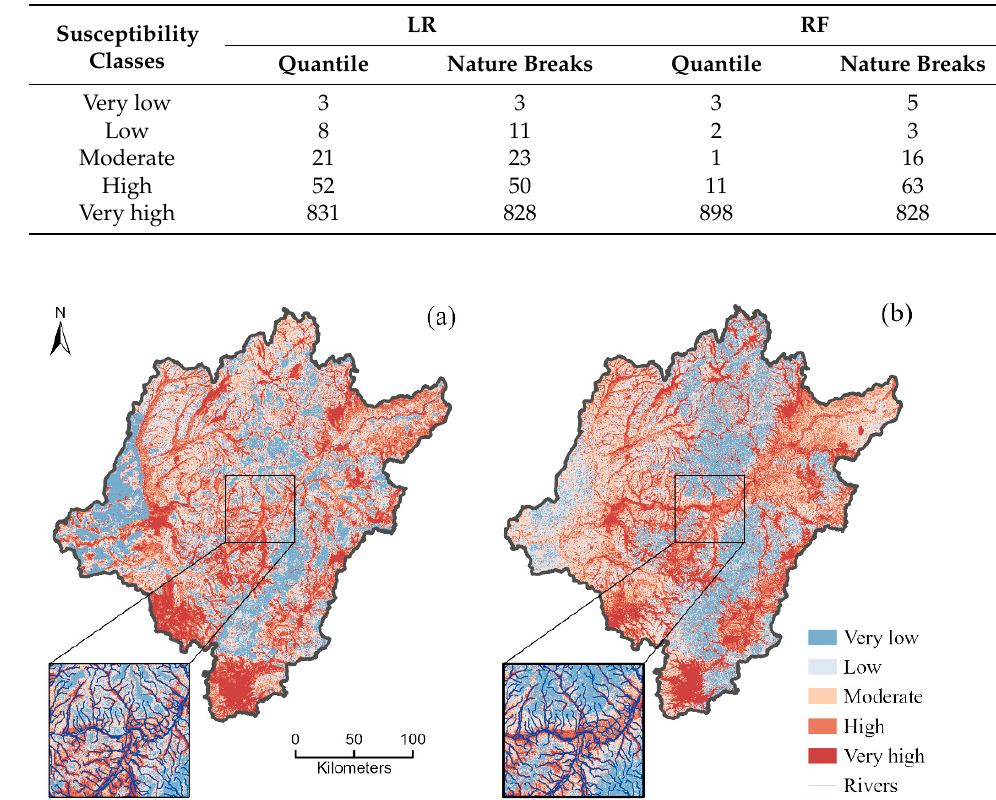
Figure 9. The FFSMs of the study area generated by the LR ( a ) and RF ( b ) models. Moreover, the pixel-level statistics for the FFSMs obtained with the two models were calculated (Figure 10). The statistical results of the two models differ to some extent. Compared with that of the LR model, the FFSM of the RF model exhibited more fluctuating pixel distributions for all classes. Extreme susceptibility classes, such as the very low and very high susceptibility classes, included fewer pixels, while the moderate and low susceptibility classes had the most pixels. However, the pixel counts of the two models were similar for the high-susceptibility class.